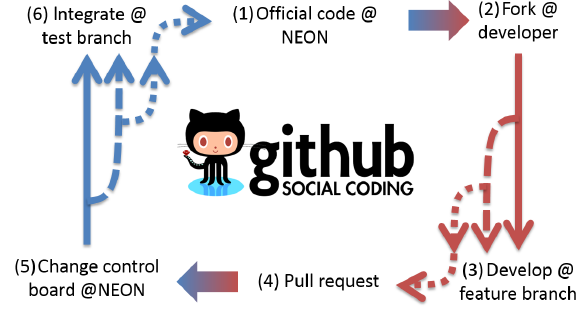
Figure 3. NEON’s Git workflow. Please see text in Sect. 2.2 for a detailed